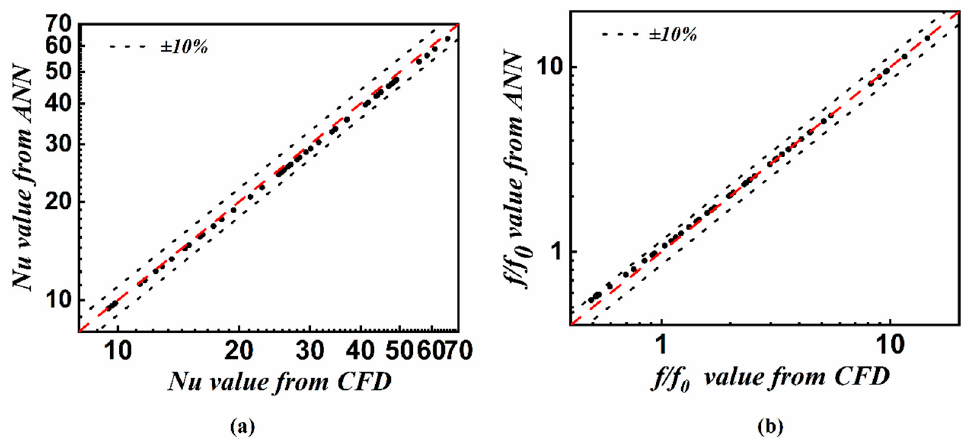
Figure 17. Deviations between CFD simulation results and ANN fitting results: ( a ) Nu and ( b ) f / f 0 .